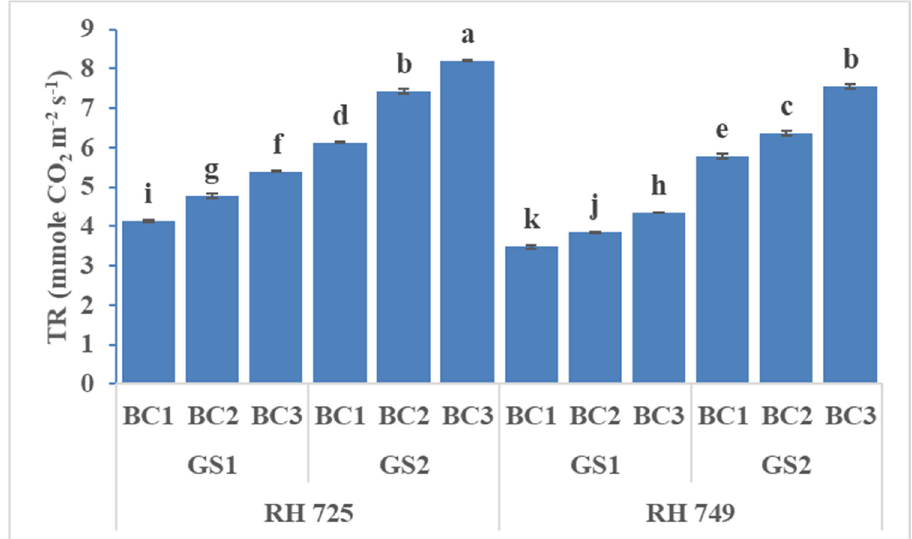
Figure 3. Comparisons of the effects of different concentrations of brassinolide sprays (BC1: control (water spray); BC2: 10 mg BRs/L water; BC3: 20 mg BRs/L water) on the transpiration rate (TR) of drought-tolerant (RH 725) and drought-sensitive (RH 749) Indian mustard cultivars at the flower initiation (GS1) and 50% flowering (GS2) stages. Columns marked by different letters indicate significant differences ( p < 0.05) between treatments based on Duncan’s multiple range test. Error bars denote the standard errors of the mean.